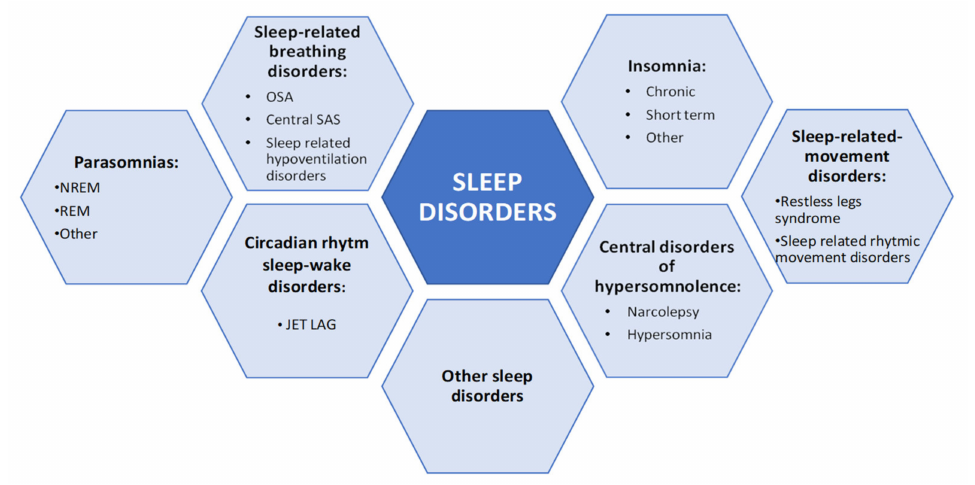
Figure 1. Schematic representation of sleep disorders (ICSD-3). NREM: non-rapid eye movement, REM: rapid eye movement, OSA: obstructive sleep apnea, SAS: sleep apnea syndrome.